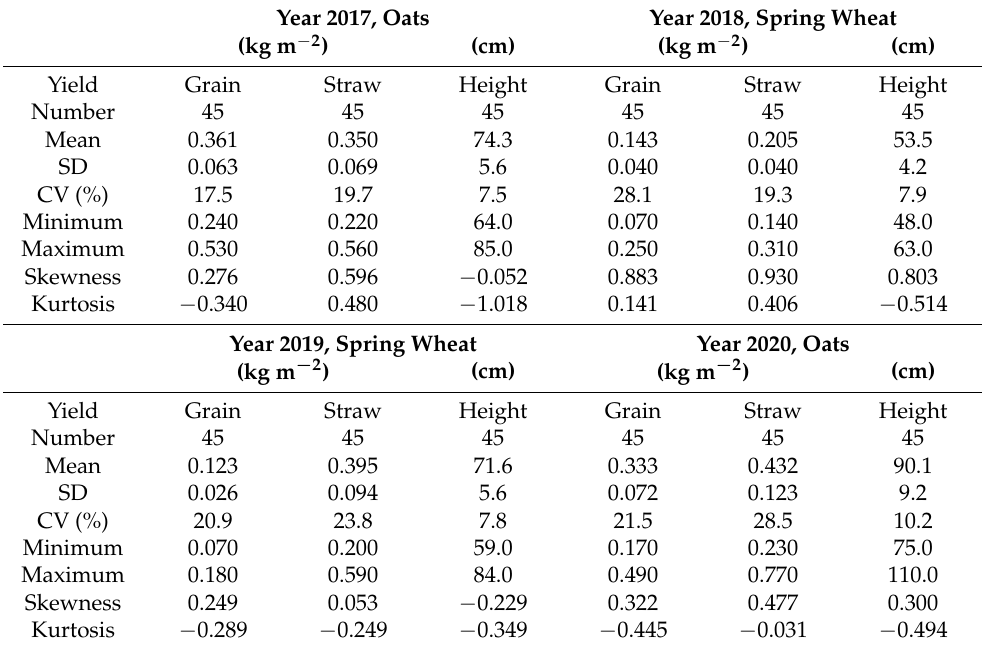
Table 1. Basic statistics for cereal yield trait components during the period of